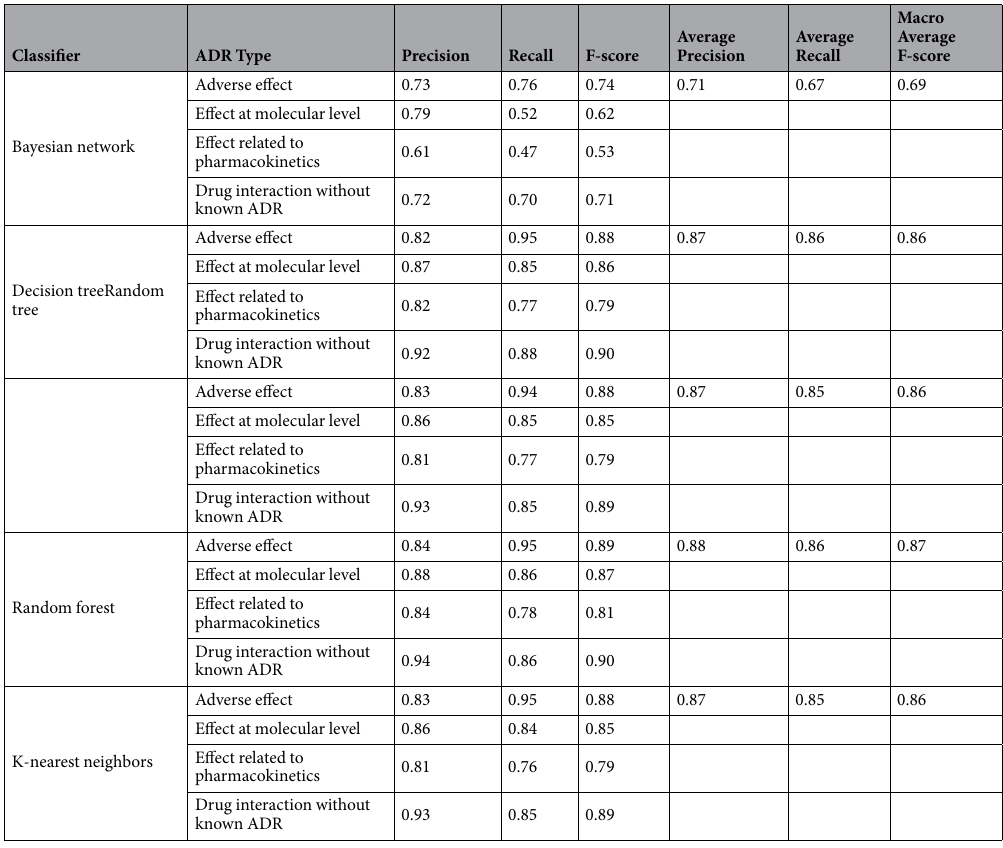
Table 3. Performance of classification on ADR types using DDI features on DDI corpus training